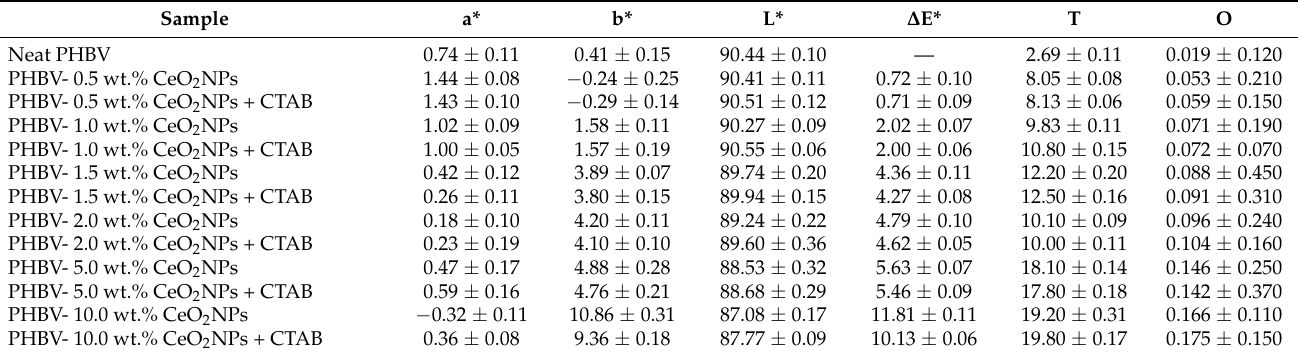
Table 1. Optical characterization expressed in terms of the color parameters (a*, b*, L*, and ∆ E*) and transparency results of electrospun poly(3-hydroxybutyrate-co-3-hydroxyvalerate) (PHBV) films loaded with cerium oxide nanoparticles (CeO 2 NPs) and hexadecyltrimethylammonium bromide